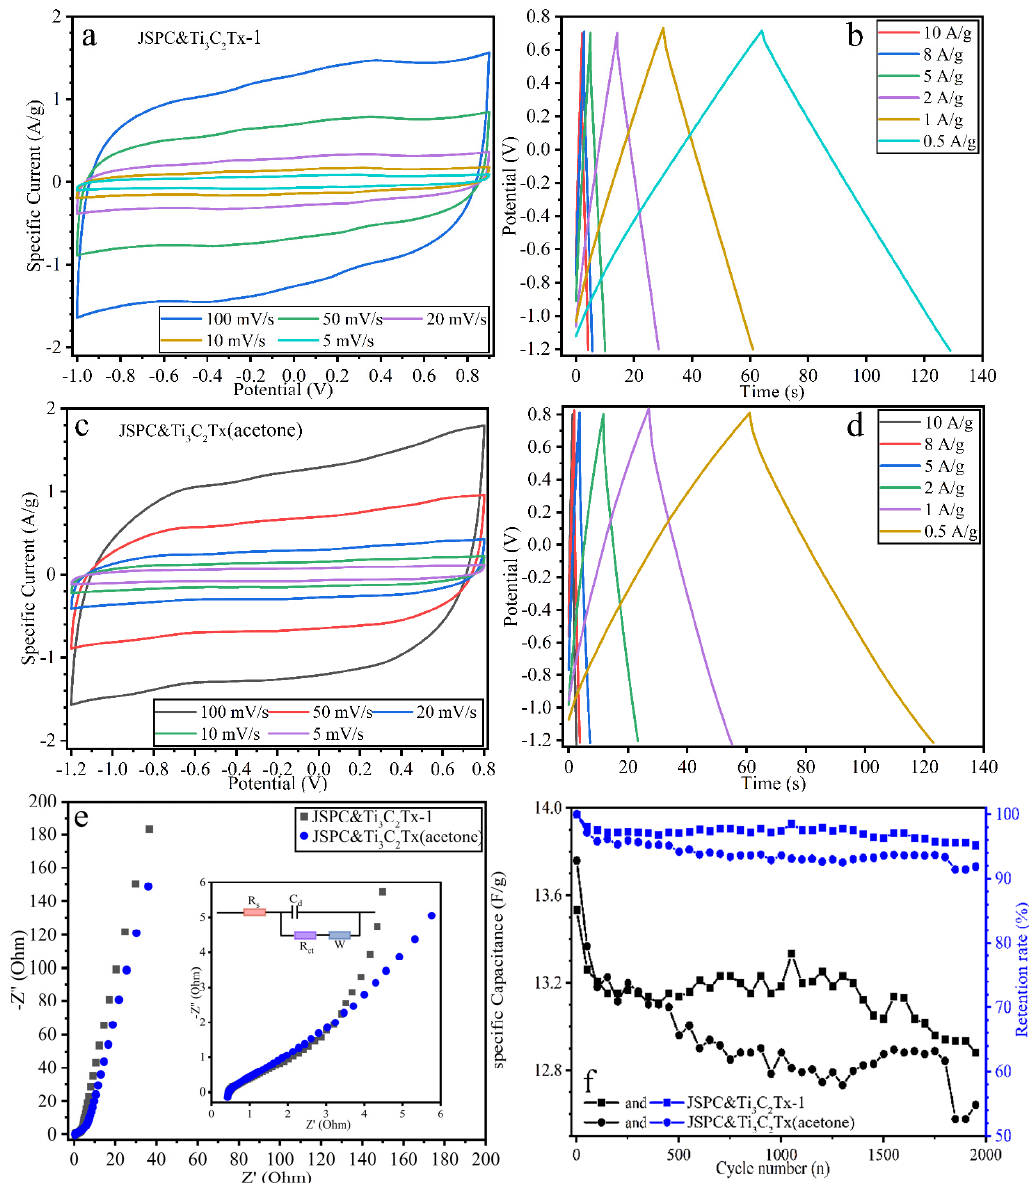
Figure 6. Electrochemical characteristics of the device. ( a , b ) refer to the CV and GCD from JSPC&Ti 3 C 2 Tx-1. ( c , d ) refer to the CV and GCD from JSPC&Ti 3 C 2 Tx (acetone). ( e ) is the EIS curve. ( f ) is the cyclic